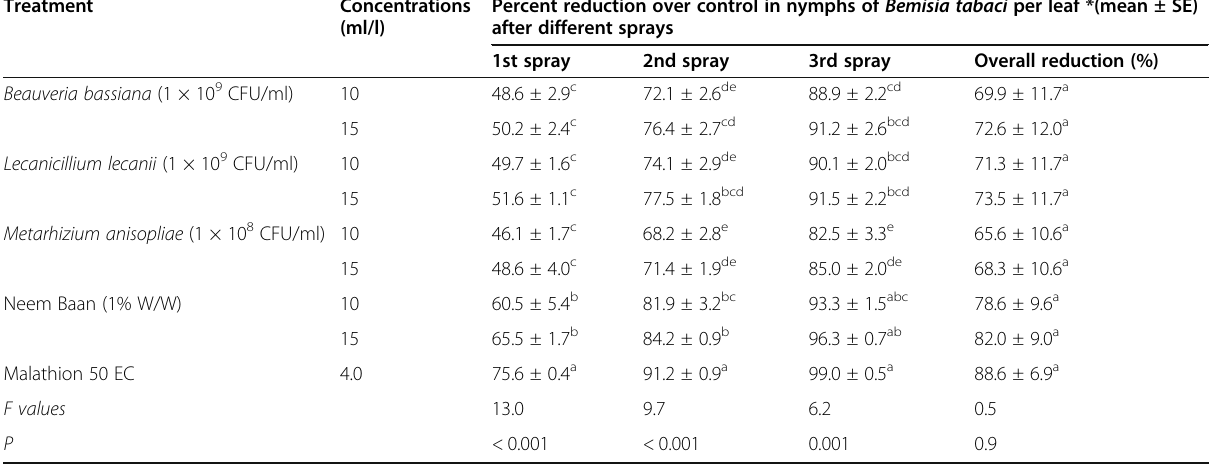
Table 4 Efficacy of different biopesticides against nymphs of Bemisia tabaci on cucumber under net house conditions during autumn cropping season (2017)